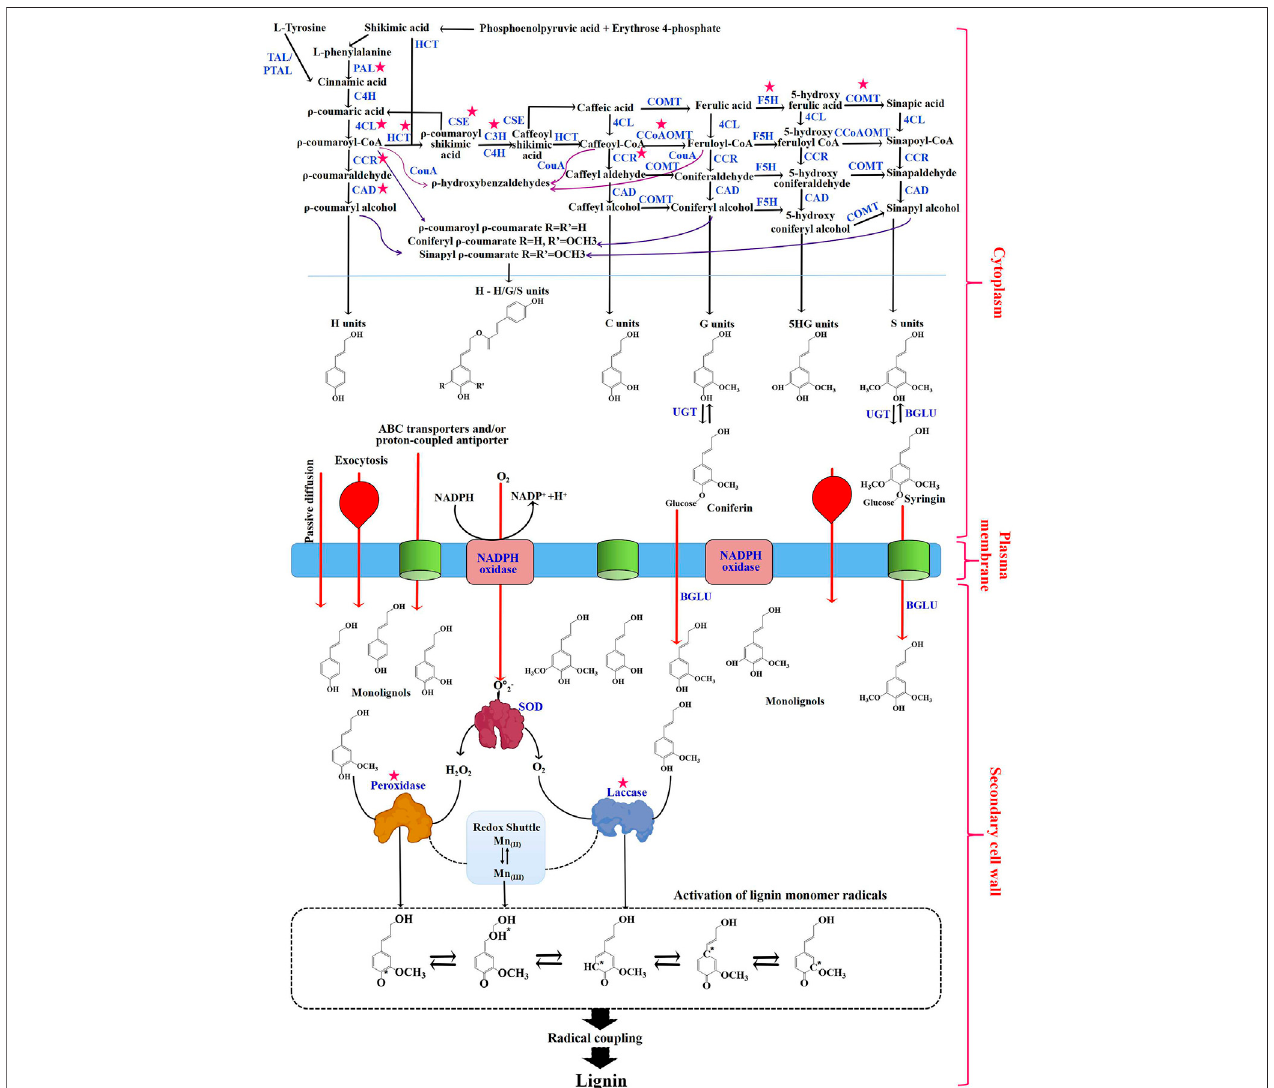
FIGURE 1 | The general lignin biosynthesis pathway. Red arrows indicate the transport of monolignols from the cytoplasm through the plasma membrane into the secondary cell wall through passive diffusion/exocytosis/ATP-binding cassette (ABC) transporters. Dotted lines between the peroxidase/redox shuttle and laccase/ redox shuttle indicate the regeneration of Mn [III] by laccase and peroxidase. Chemical structures in the dotted box represent activated monolignol radicals. Red stars indicate potential targets for plant genetic engineering to reduce lignin content and modulate the monomer composition of lignin. Abbreviations: TAL, tyrosine ammonia-lyase; PTAL, bifunctional phenylalanine and tyrosine ammonia-lyase; PAL, phenylalanine ammonia-lyase; C4H, cinnamate 4-hydroxylase; 4CL, p-coumarate: CoA ligase; HCT, hydroxycinnamoyl-CoA:CCR-cinnamoyl-CoA reductase; CAD, cinnamyl alcohol dehydrogenase; CSEvcaffeoyl shikimate esterase; C3H, ρ - coumarate 3-hydroxylase; COMT, caffeic acid O-methyltransferase; CCoAOMT, caffeoyl-CoA O-methyltransferase; F5H, ferulate 5-hydroxylase; CCR, cinnamoyl-CoA reductase; CouA, hydroxycinnamoylCoA hydratase/lyase; UGT, UDP-glucosyltransferase; BGLU, β -glucosidase and SOD, superoxide dismutase.